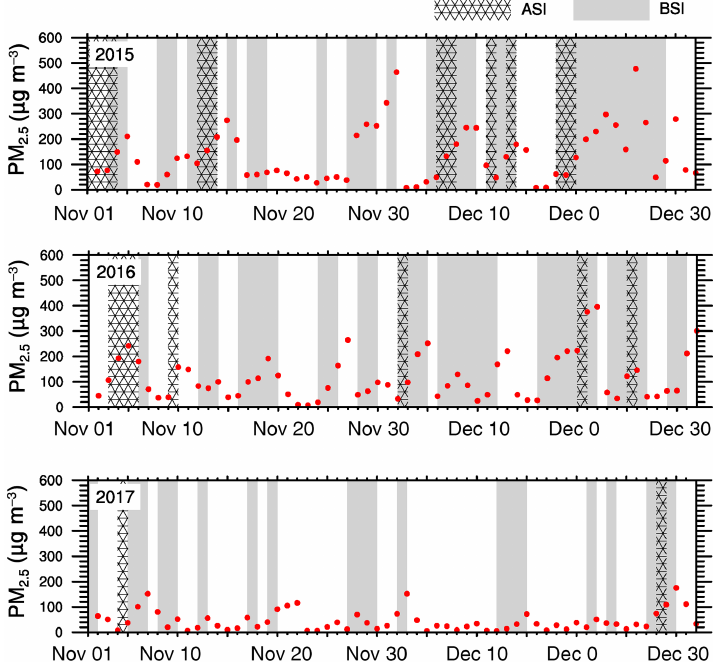
Figure 14. Time series of 24h averaged concentration of PM 2 . 5 of Beijing from November to December during 2015–2017. Stagnation days under the ASI and BSI metrics are marked with stripes and grey colors, respectively.